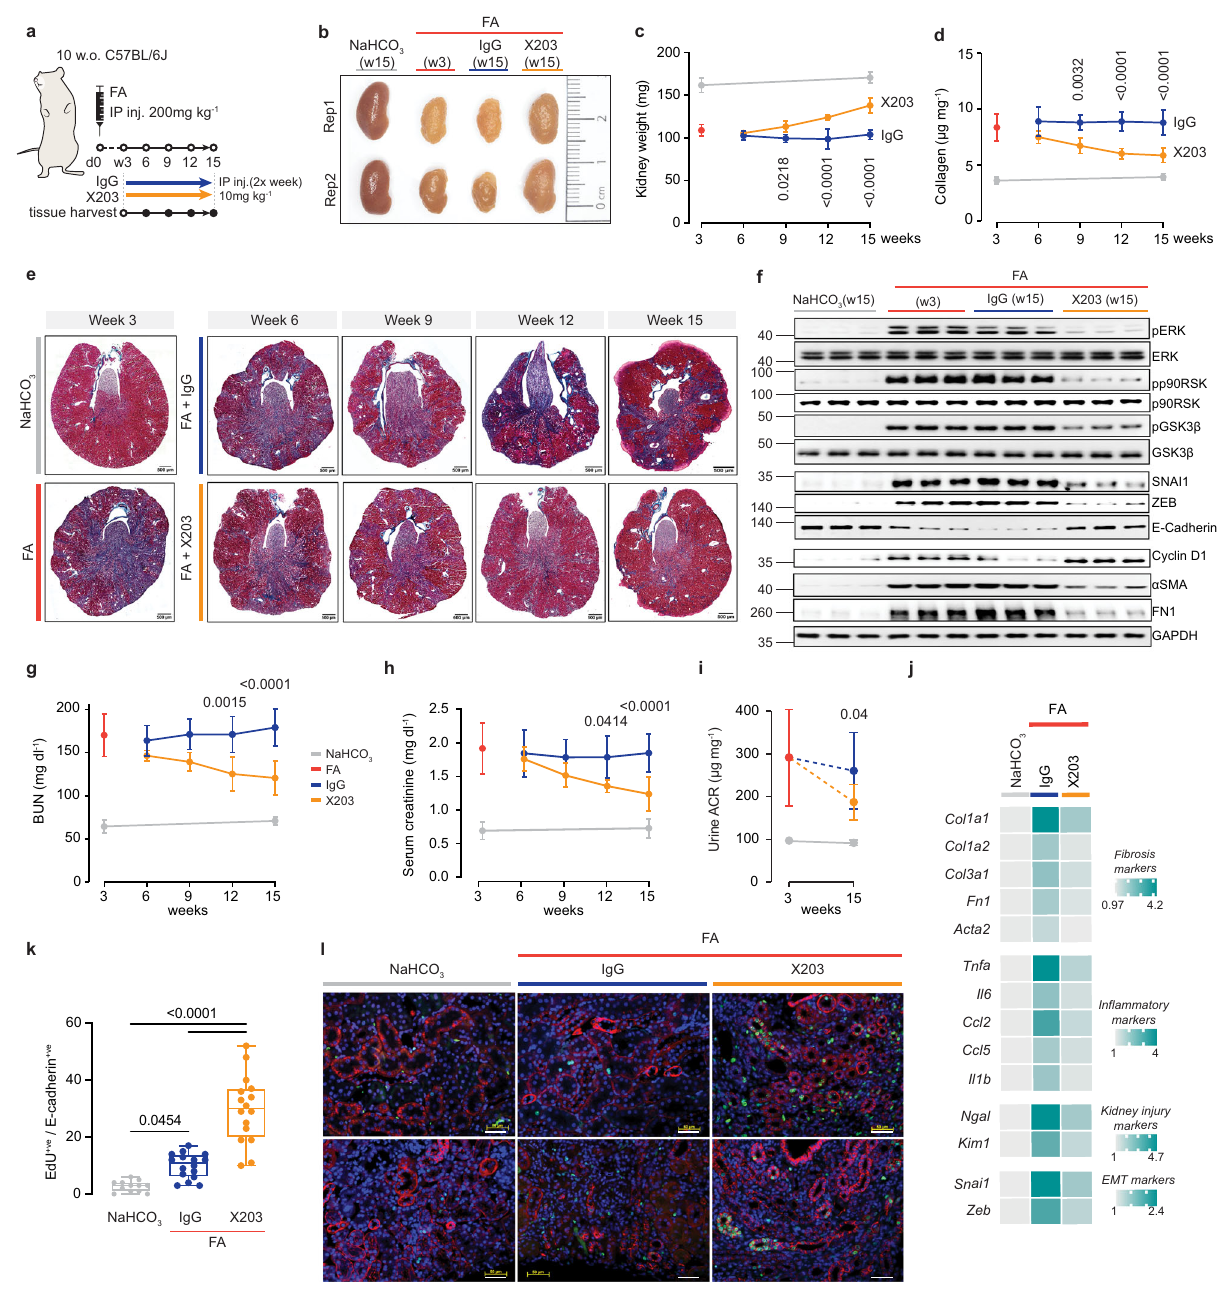
Fig. 9|Anti-IL11promoteskidney regenerationandreversesrenaldysfunction in chronic kidney disease. a Schematic of X203 therapeutic dosing regimen for CKD reversal experiments shown in ( b – l ): X203 or IgG (IP, 10mg/kg) was admi- nistered 2X/week for 12 weeks from day 21 (week 3) after FA injury, when CKD is established and sustained. Blood and kidneys were collected every 3 weeks; full course serum and kidney phenotyping study were performed at the study end- point (week 15: 12 weeks after the start of X203 therapy); blood and kidneys from control mice i.e., those receiving IP injection of vehicle control (0.3M NaHCO 3 ) were collected at week 3 and 15. b Representative kidney gross anatomy, c kidney weights (NaHCO 3 (W3), FA (W3) ( n =11/group), FA+IgG (W6, W9), FA+X203 (W6, W12) ( n =4/group), FA+X203 (W9), FA+IgG (W12), NaHCO 3 (W15) ( n =5/group), FA+IgG/X203 (W15) n =13/group)), d renal collagen content by hydroxyproline assay, e representative Masson ’ s Trichrome images of whole kidney cross section (scale bars: 500 µ m, representative dataset from n =4/group for kidneys collected at week 6, 9, 12 or from n =5/group for week 3 and 15), f Western blots showing renal ERK and p90RSK activation, GSK3 β inactivation, and SNAI1, ZEB, E- Cadherin, Cyclin D1, α SMA, FN1, GAPDH expression (representative dataset from